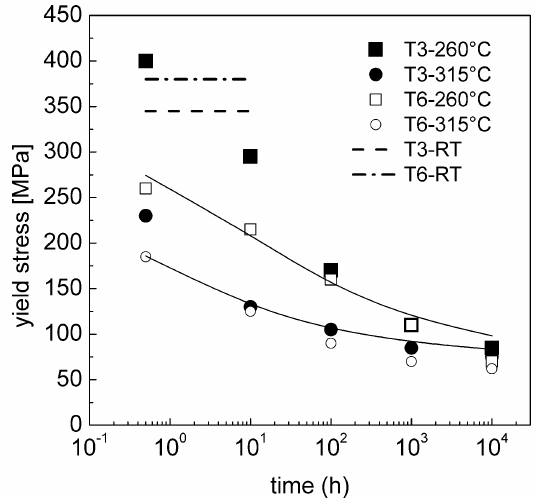
Figure 4. Calculated variation of the yield stress for AA2024 T6; the symbols represent the experimental data from Reference [36] for the T3 and T6 states, tested at room temperature. Initial rod diameter 3.4 nm, volume fraction of the intragranular S-phase 0.9% at 250 °C and 0.6% at 315 °C respectively. The figure also reports the yield strength at room temperature for the unexposed T3 and T6 states [36].